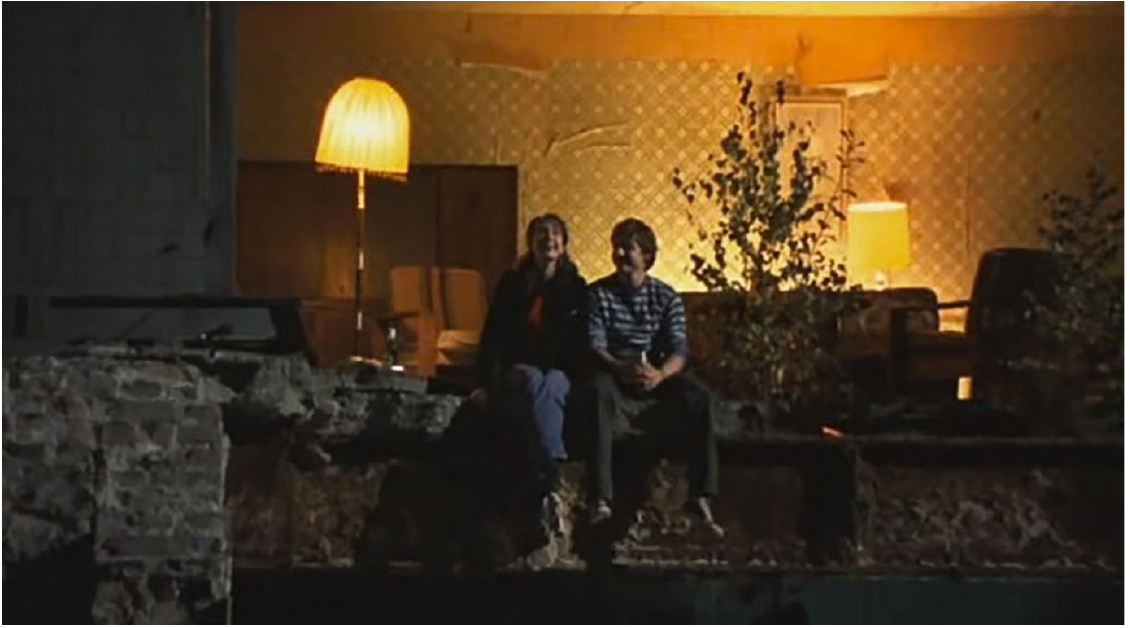
Figure 8 Alex and Lara sitting on a ruined